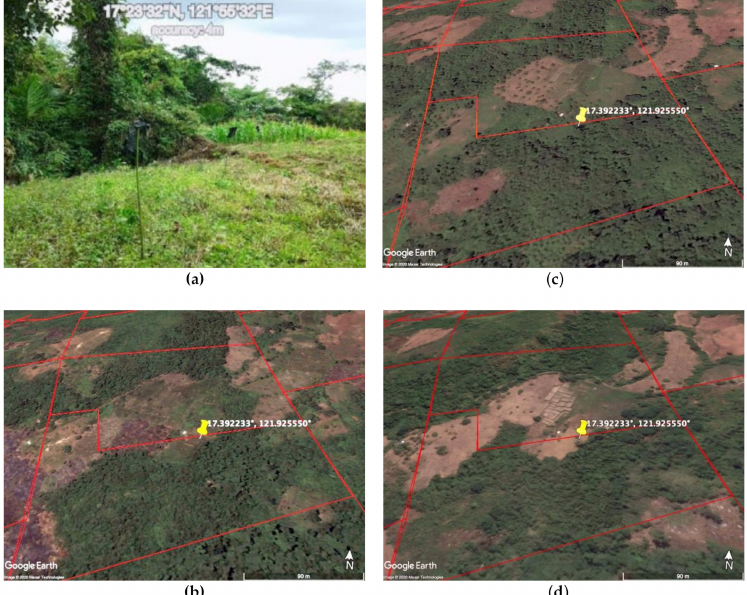
Figure 13. ( a ) Geotagged photo of the NGP site in the Sierra Madre and corresponding VHR RGB images taken on ( b ) 25 April 2012; ( c ) 26 May 2015; and ( d ) 18 June 2018, and accessed through Google Earth Pro. Pin location: 17.392233 ◦ , 121.925550 ◦